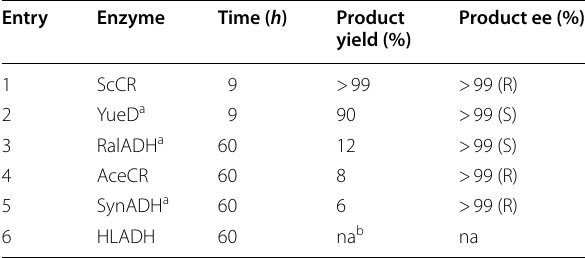
Table 1 Asymmetric synthesis of 3A5HEF catalyzed by CRs/